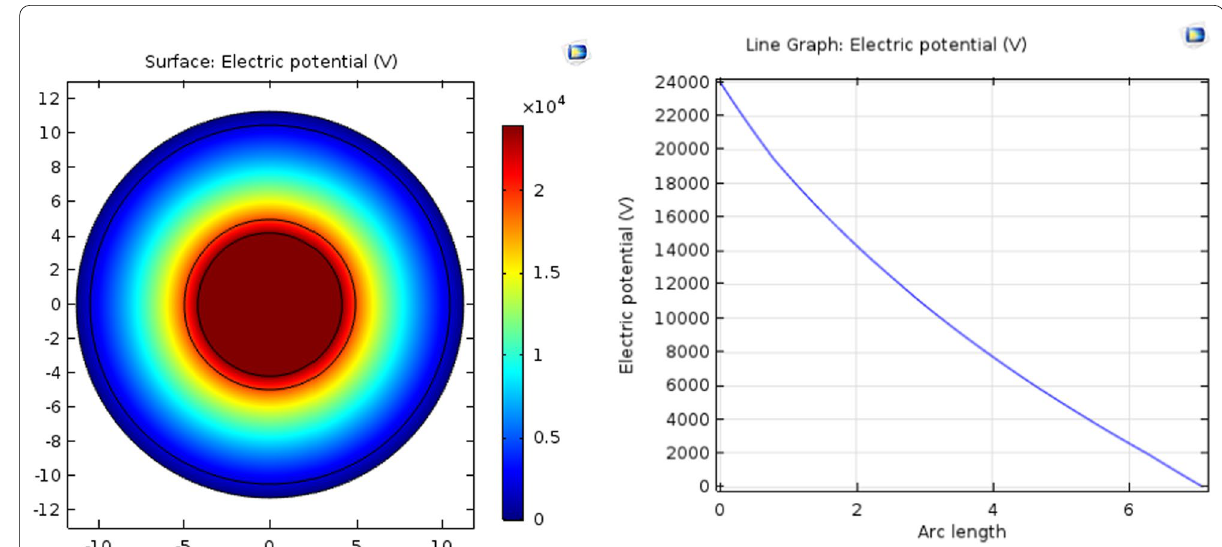
Fig. 10 Electric potential distribution in medium‑voltage (MV) cross‑linked polyethylene‑marked cables without zinc oxide (ZnO) filling